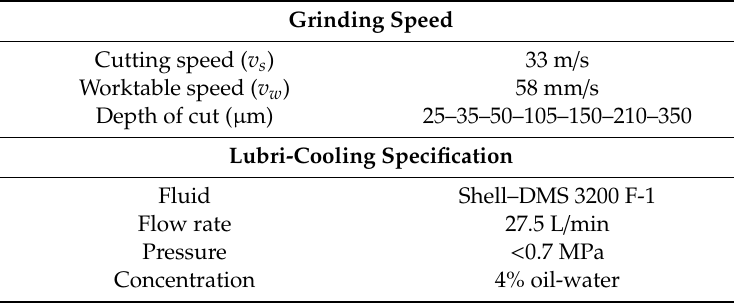
Table 1. Grinding